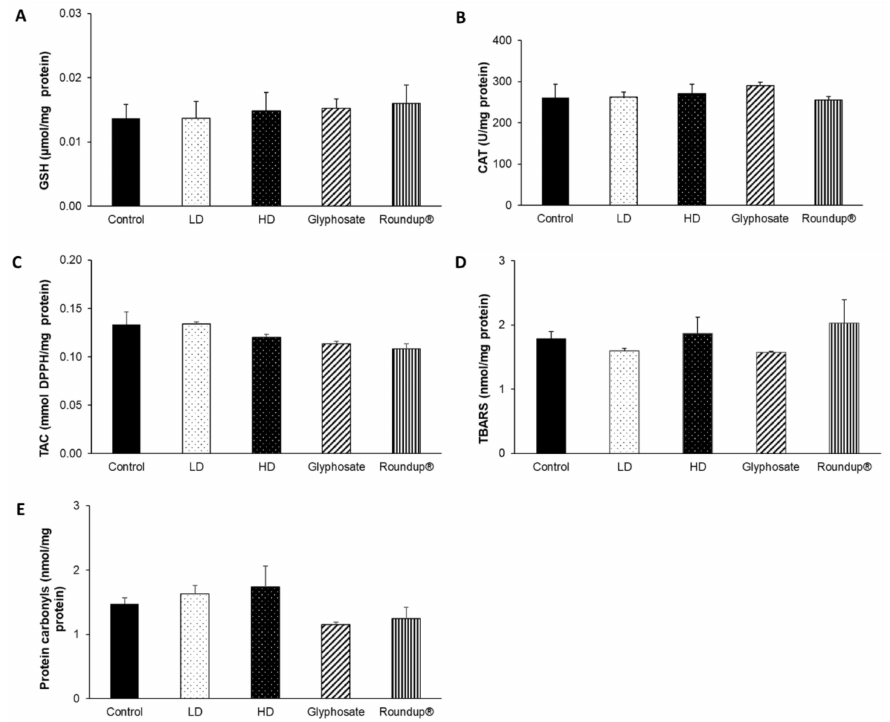
Figure 8. The effects of 12-month exposure of New Zealand rabbits to the EDs mixture, glyphosate, and Roundup ® on right kidney GSH concentration ( A ), CAT activity ( B ), TAC levels ( C ), TBARS levels ( D ), and protein carbonyls concentration ( E